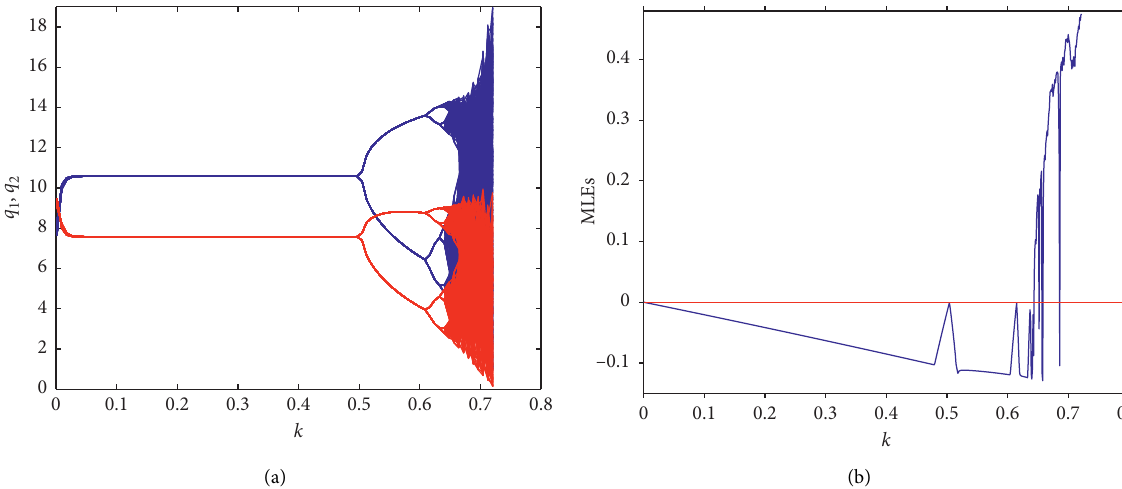
� 0 . 2 , c � 0 . 3, and 1 2